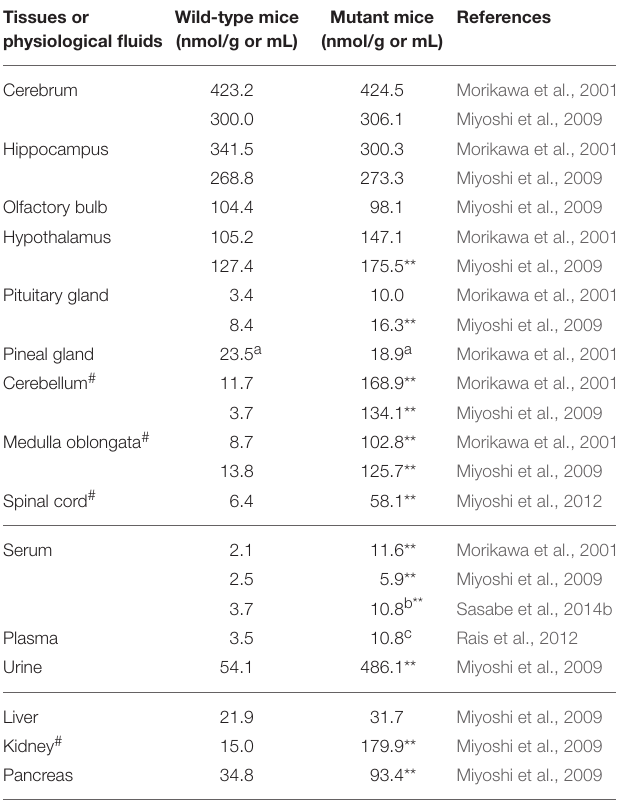
TABLE 4 | Amounts of D -serine in the tissues and physiological fluids of wild-type mice and mutant mice lacking DAO activity. Tissues or Wild-type mice Mutant mice physiological fluids (nmol/g or mL) (nmol/g or mL)